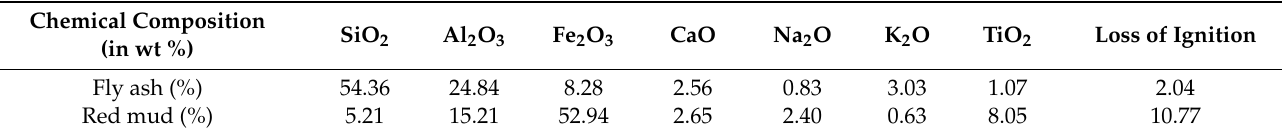
Table 1. Chemical composition of the raw materials used in this study.